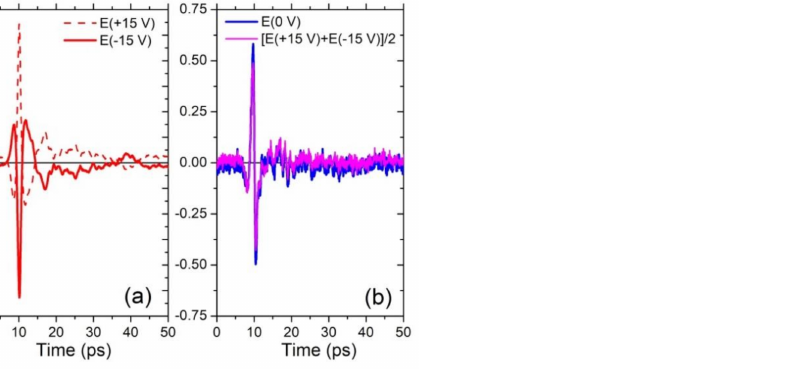
Figure 6. The ( a ) THz pulses at opposite bias voltages; and ( b ) comparison of the unbiased THz pulse (blue) with the result of averaging of two waveforms from oppositely biased antennas